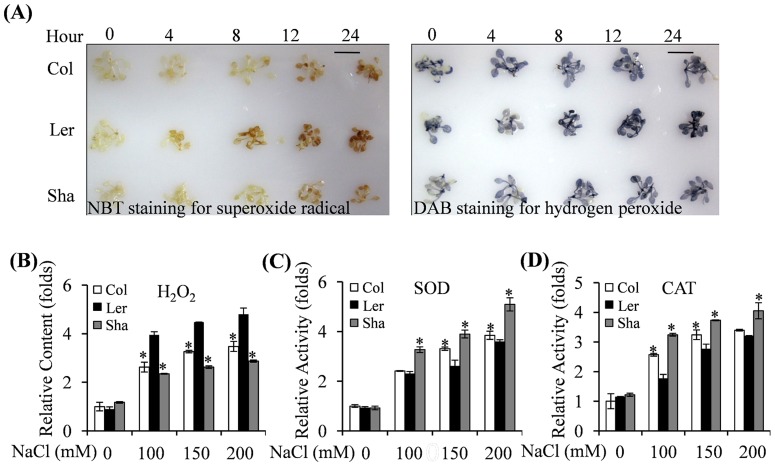
Quantitative comparison of superoxide contents and antioxidant enzyme activities (SOD and CAT) among Col, Ler and Sha after salt stress treatment.Two-week-old plants were started to be treated with the indicated concentrations of NaCl for 10 days before measurement in (B), (C) & (D). The values indicated means + SEs of two independent experimental repeats in (B), (C) & (D) (n = 15). * indicated significant difference with P<0.05 (t-test) in relative to Ler. (A) Visualization of superoxide radical and hydrogen peroxide detected by NBT and DAB staining. Detections have been done on 2-week-old MS-grown plants subjected to subsequent treatment with 200 mM NaCl for the indicated time. Bar = 1 cm. (B) Changes in H2O2 content were analyzed with different salt treatment. (C) Changes in SOD activity were analyzed with different salt treatment. (D) Changes in CAT activity were analyzed with different salt treatment.